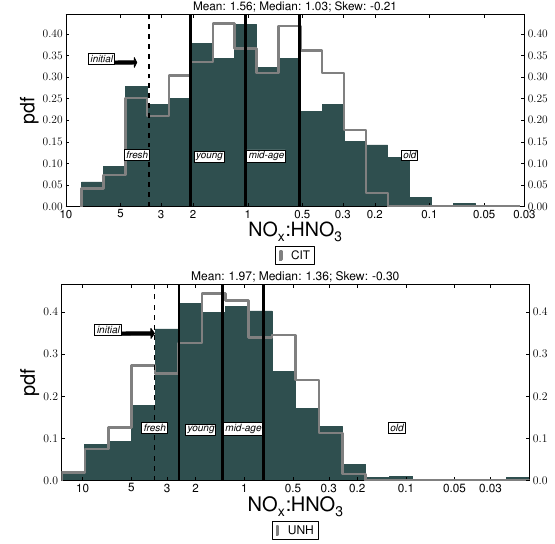
Fig. A4. Observed NO x :HNO 3 (bars; left: CIT, right: UNH) com- pared to simulated (lines) from the GEOS-Chem chemical mecha- nism using the optimized, bias-corrected statistical model.